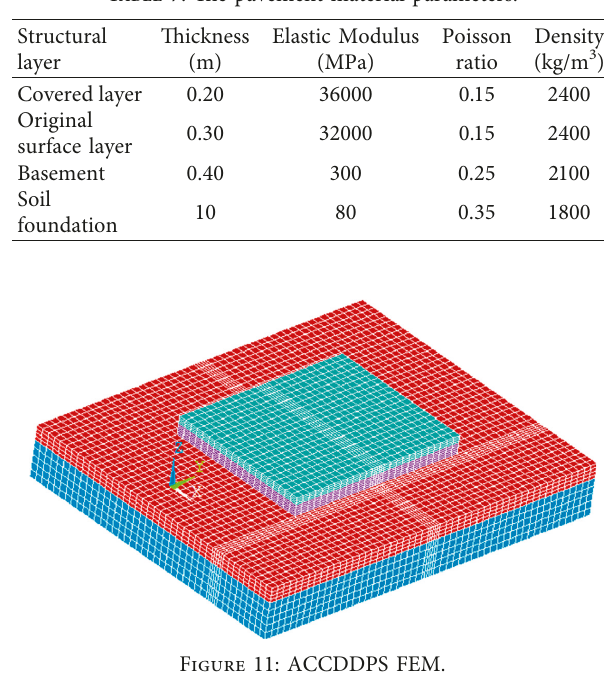
Figure 10: Conversion schematic diagram of the contact surface. Table 6: Square size for various types od aircraft wheel. Table 7: The pavement material parameters.